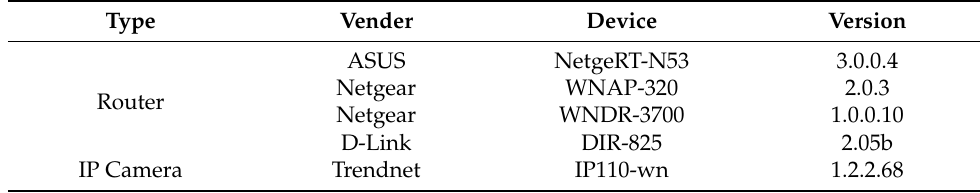
Table 1. IoT devices for testing.